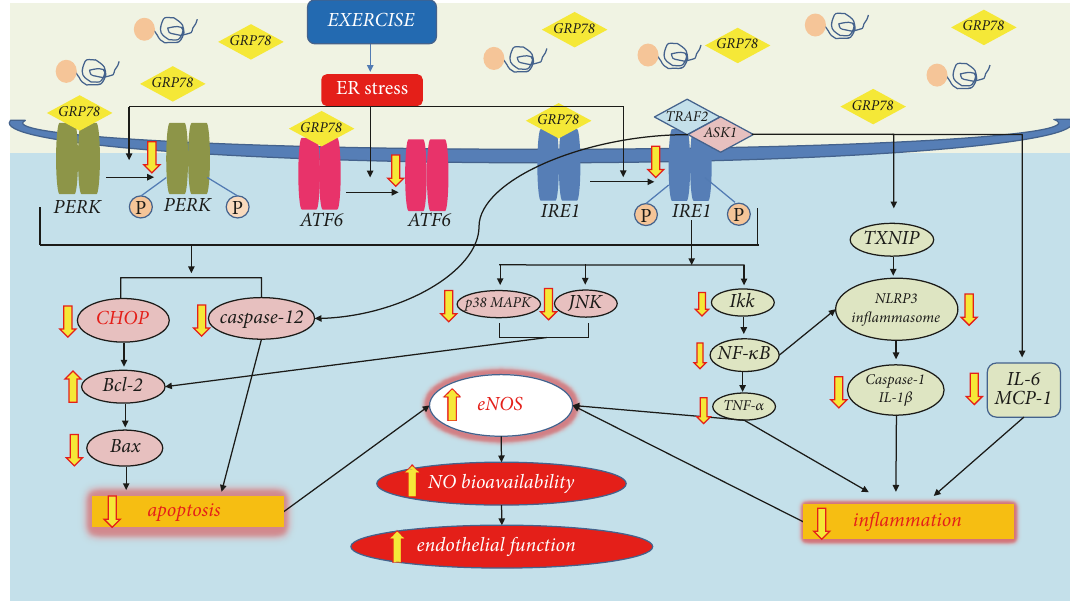
Figure 2: The Chronic effect of exercise on the ER stress-associated apoptosis and inflammation. Regular exercise reduces phosphorylation of the three ER stress sensors and inhibits or decreases ER stress-associated apoptosis and inflammation signaling pathways. Exercise training ameliorates ER stress-mediated CHOP signaling, in turn reducing apoptosis. Exercise training also reduces IRE1 𝛼 -mediated p38 MAPK/JNK and NF- 𝜅 B-associated inflammasome regulating the expression of caspase-1, IL-1 𝛽 , IL-6, and MCP-1, mitigates the IRE1 𝛼 /TRAF2/ASK1 complex that links to caspase-12, and mediates apoptosis in cardiovascular disease. As a result, these signaling pathways systemically mediate eNOS expression through the decreased apoptosis and inflammation, which increase NO bioavailability and improve endothelial function. The yellow arrows represent the exercise-induced changes in ER stress-mediated apoptosis and inflammatory